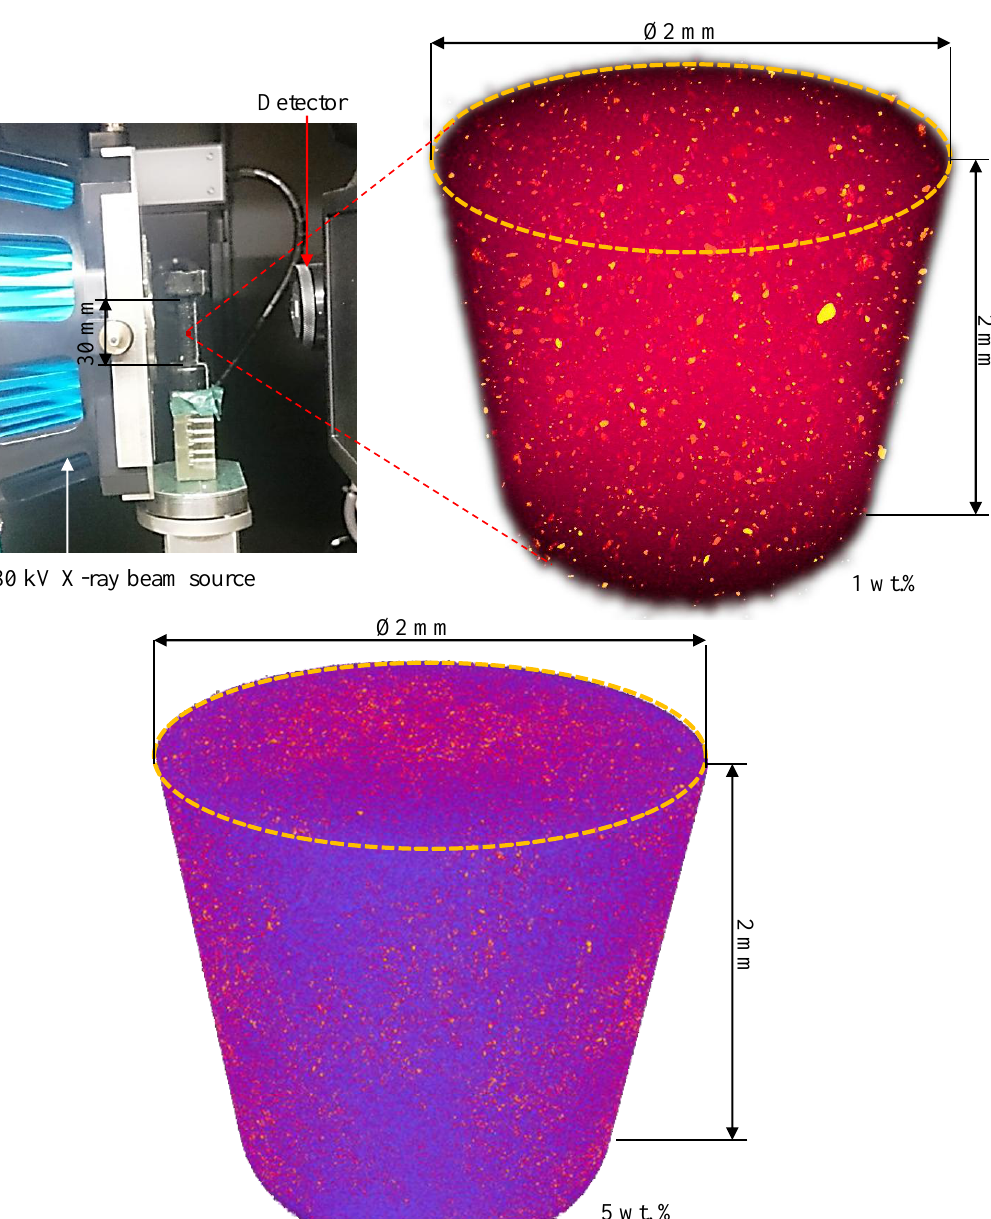
Figure 4. 3D X-ray computed tomography of 1 and 5 wt % CNP embedded epoxy (yellow spots represent CNPs as nanoclusters) at the center of test specimens covering a cylindrical region of Ø 2 mm × 2 mm; results for 1 wt % specimens show large discrepancies in the size of CNPs while small discrepancies for 5 wt % specimen.